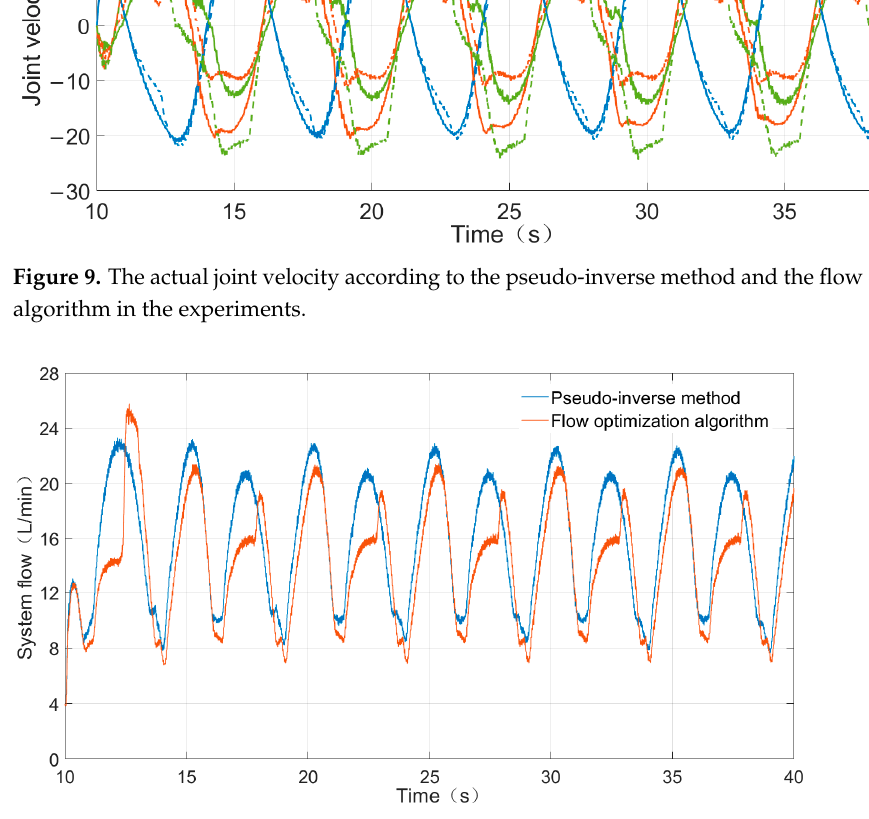
Figure 10. Flow optimization algorithm experiment—the comparison diagram of system flow.